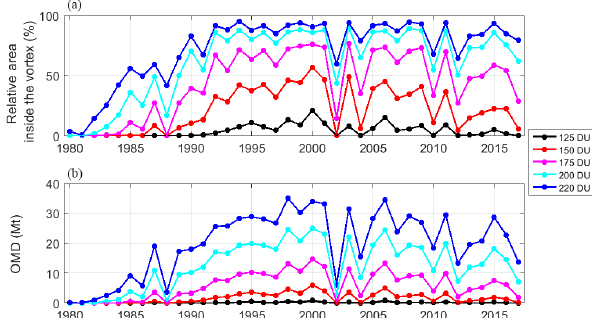
Figure 12. Relative area inside the vortex (in percent) with values lower than five level thresholds (125, 150, 175, 200 and 220DU) computed from MSR-2 dataset using 400–600K classification on 15 September–15 October period (a) . OMD (in Mt) time series computed from MSR-2 total ozone data for the same five thresh- olds and time period are displayed in panel (b) .